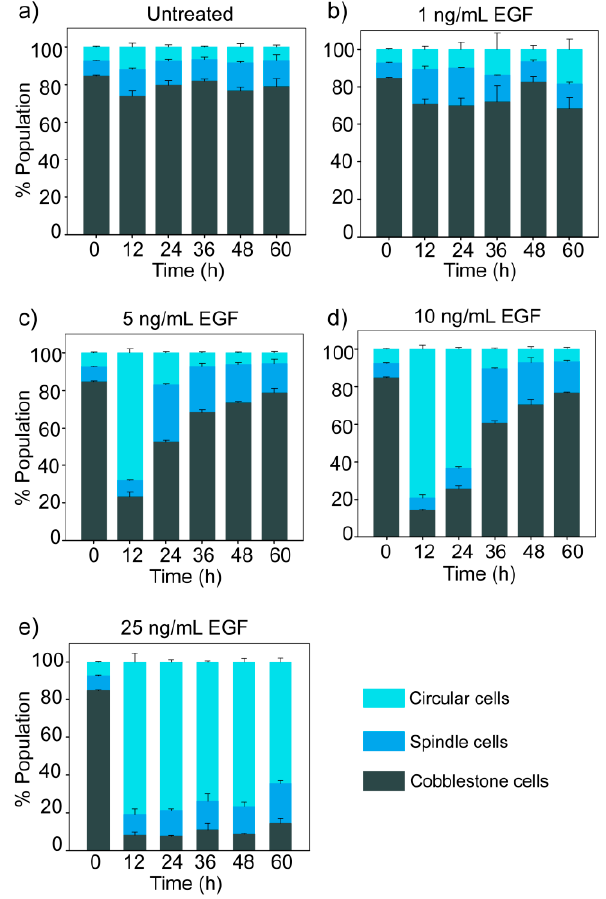
Figure 3. Dose- and time-dependent effect of EGF on population distribution. MDA-MB-468 cells were treated with different doses of EGF for different durations, and cells were imaged by fluorescence microscopy. The graph represents quantitative data from image analysis. Each data point represents the mean of three independent experiments and error bars indicate standard deviation. ( a ) In the absence of EGF; ( b ) 1 ng/mL EGF; ( c ) 5 ng/mL EGF; ( d ) 10 ng/mL EGF; ( e ) 25 ng/mL EGF.